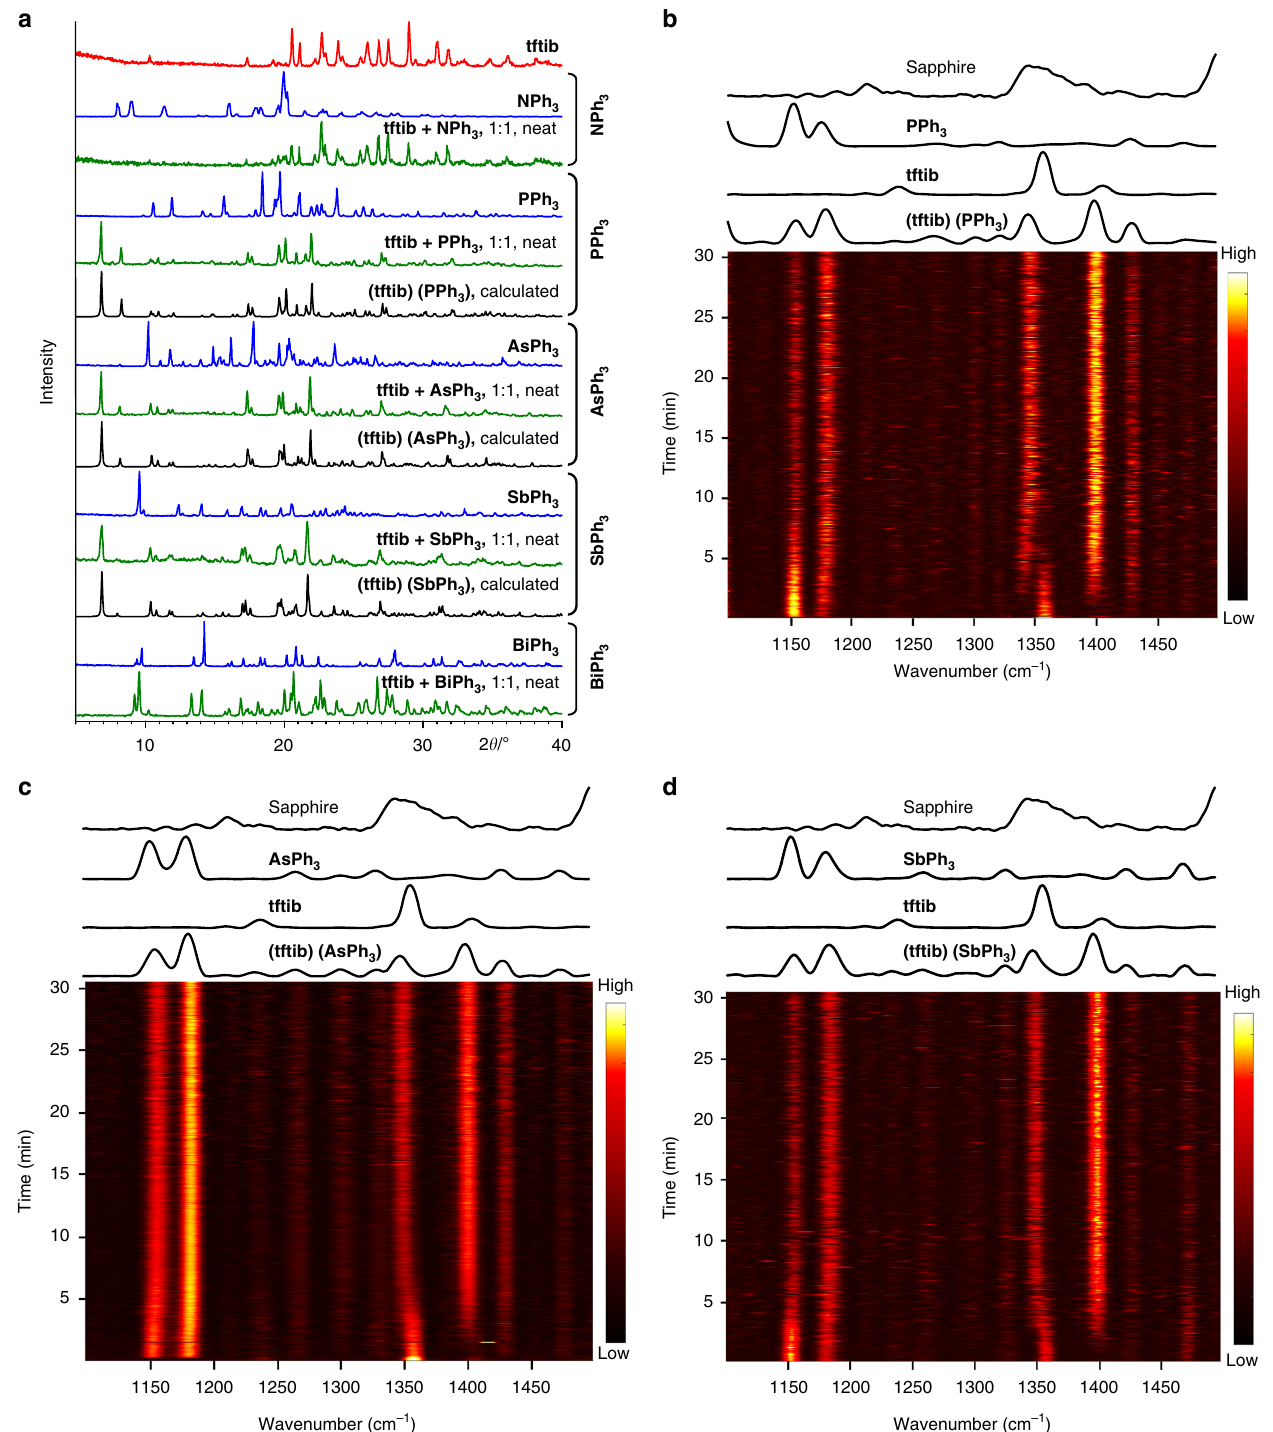
Fig. 3 Mechanochemical synthesis of the cocrystals. a Comparison of powder X-ray diffraction (PXRD) patterns relevant for the observed mechanochemical cocrystallization reactions of tftib with PPh 3 , AsPh 3 , and SbPh 3 , as well as attempted mechanochemical syntheses of ( tftib )( NPh 3 ) and ( tftib )( BiPh 3 ) by neat milling. Results of corresponding LAG experiments are shown in the Supplementary Figs. 3-7. Real-time collected time-resolved Raman spectra for the mechanochemical neat milling reactions of tftib with: b PPh 3 , c AsPh 3 , and d SbPh 3 , demonstrating the rapid formation of the corresponding